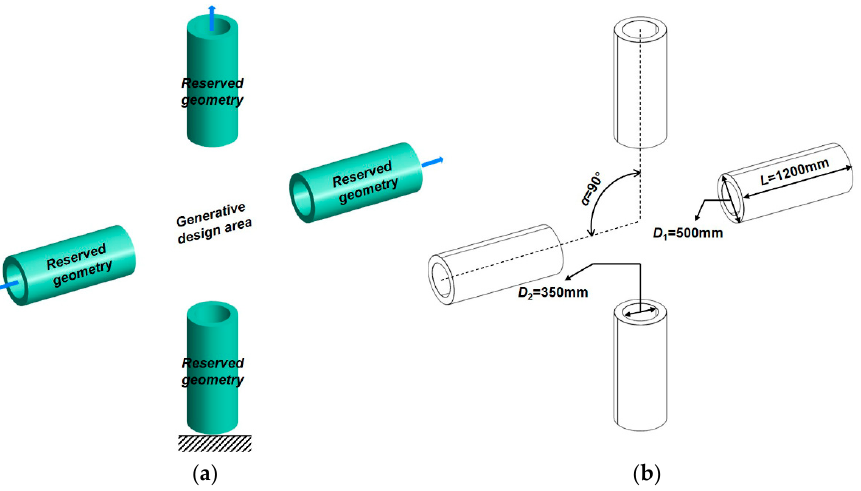
Figure 3. The initial model of a cross joint for the generative design: ( a ) initial joint model, ( b ) geometric properties.